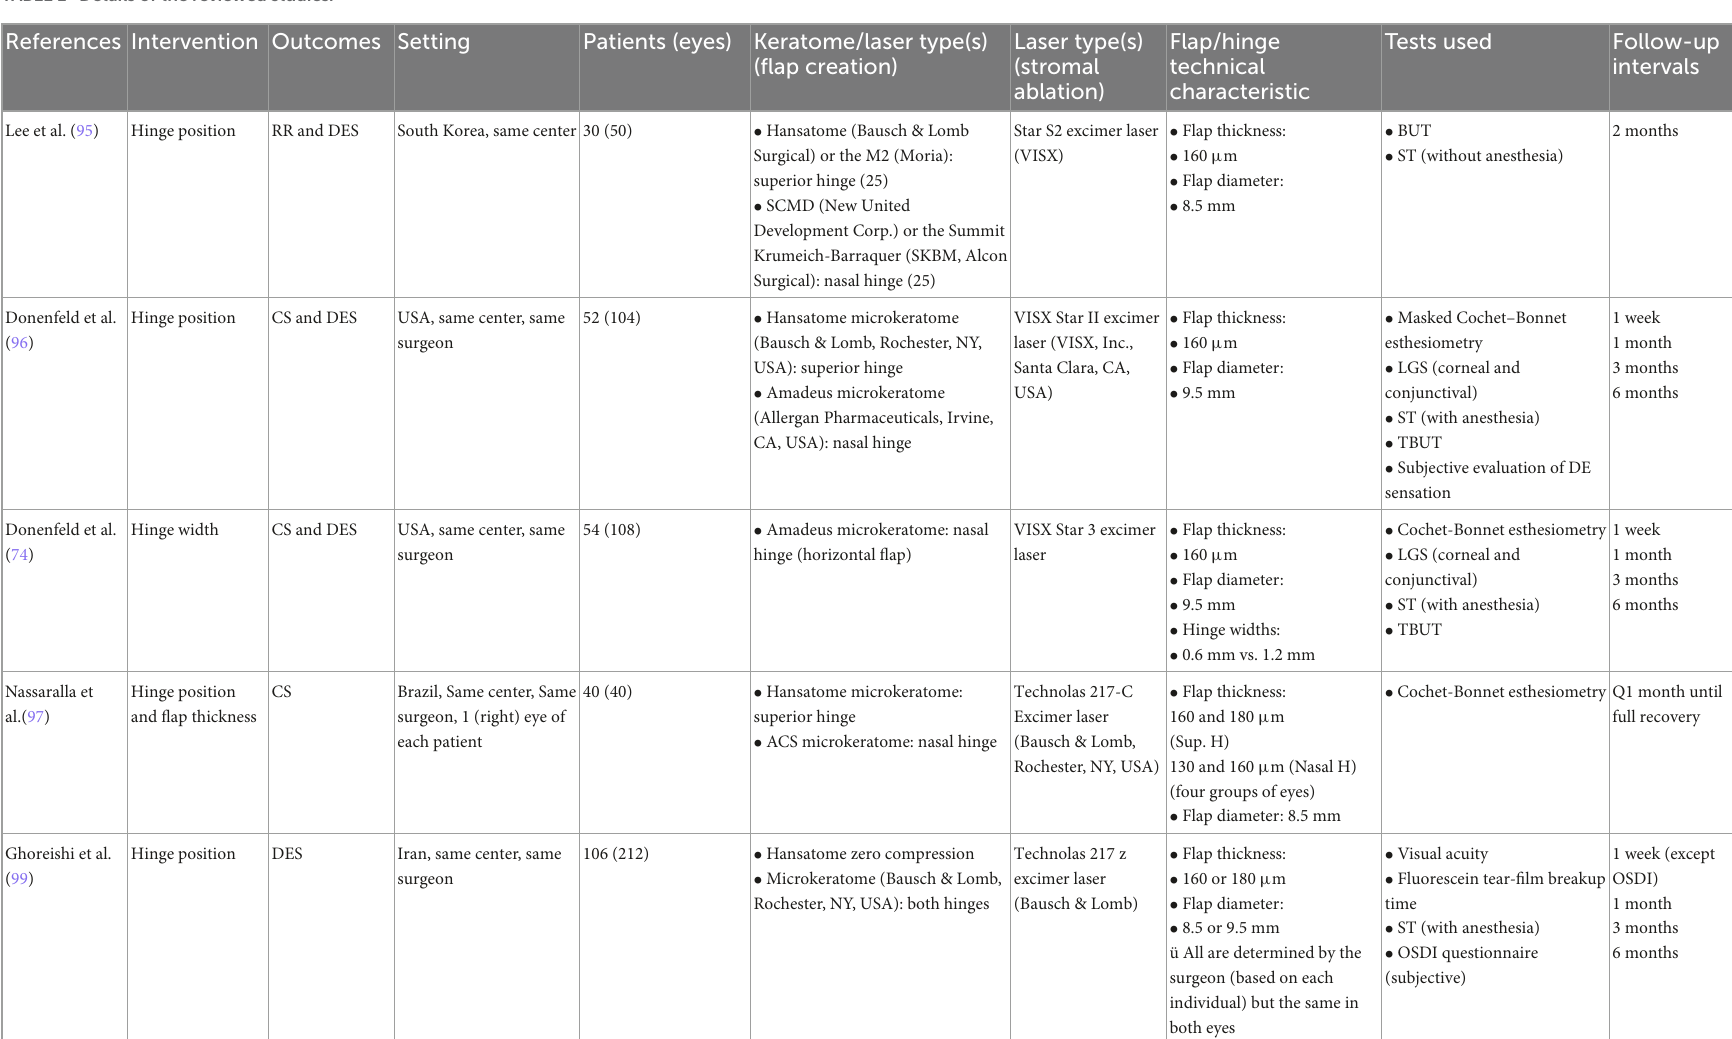
TABLE 1 Details of the reviewed